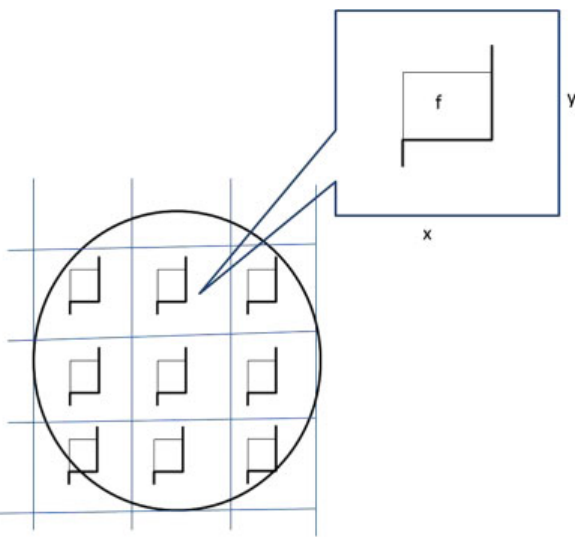
Fig. 3 Nerve cross-section for the counting principle of the axon number. The section of nerve is sampled in a systematic random manner to gain an unbiased estimation of total axon number in a nerve. Each square represents a sampling area. An unbiased counting frame is seen in the center of this area. The axons are counted if nerve fi ber is in the unbiased counting frame (f) in each sampling area. Estimates of the total number of myelinated axons are calculated as the product of the number of axons counted in a known fraction and multiplied by the inverse sampling fraction. Upper and right lines of unbiased counting frames represent the inclusion lines, whereas the lower and left lines including the extensions are the exclusion lines. Any pro fi le of myelinated nerve fi ber section hitting the exclusionlines is excluded, and pro fi le of nerve fi ber hitting the inclusion lines and located inside the frame is